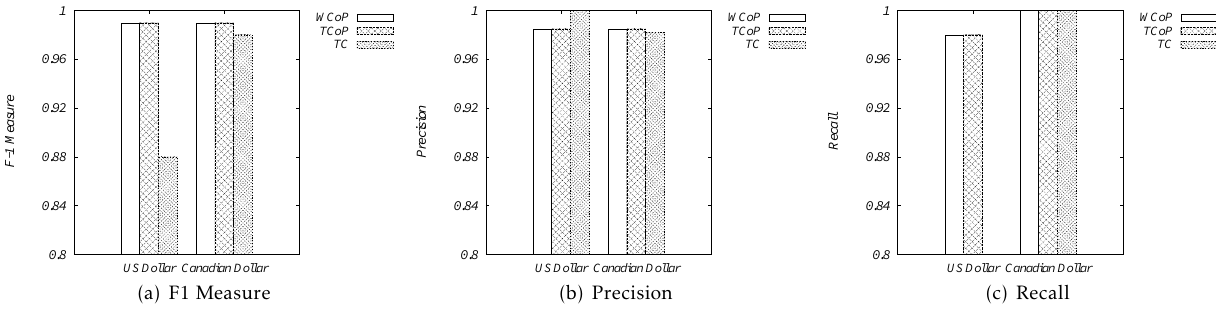
Figure 10. F1, Precision and Recall of WCoP, TCoP and Text Classification on sample pages of “Currencies"